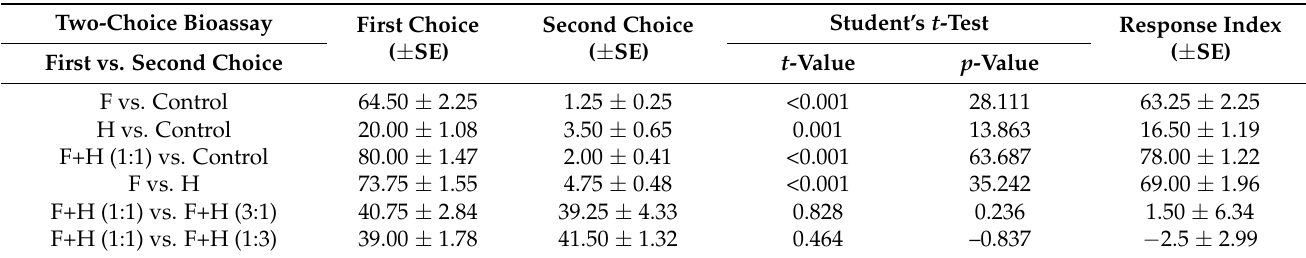
Table 2. Behavioural responses of S. granarius adults in two-choice bioassay. In a row, significant differences between first and second choices are indicated by Student’s t